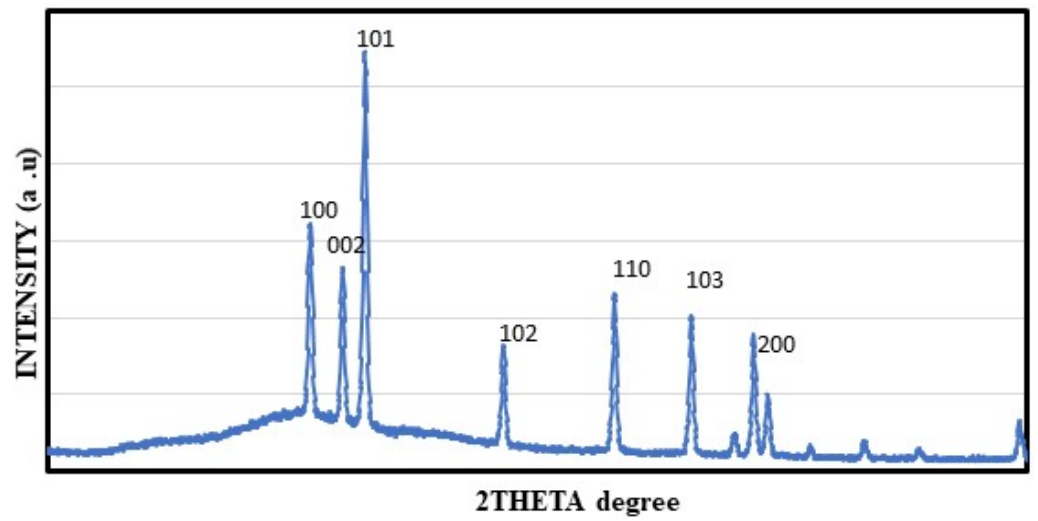
Figure 5. XRD analysis of M. indica seed extract synthesized ZnO NPs.